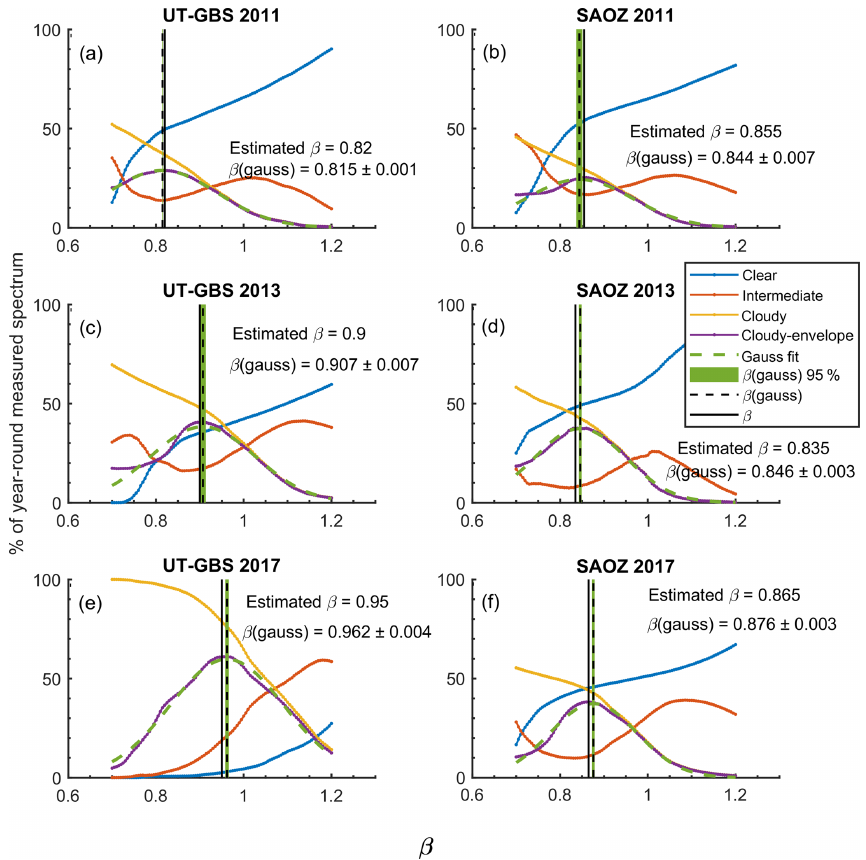
Figure 3. Examples of colour index calibration factor ( β ) determination. The y axis is the percentage of year-round measured spectra, the x axis is the β value used in the calibration. Solid lines represent measurements under different weather categories (blue for clear, red for intermediate, yellow for cloudy, and purple for cloudy envelope). Estimated values for β and the Gaussian fit, β (gauss), are shown by the vertical solid black line and dashed black lines, respectively. The vertical green shaded area is the 95% confidence bound on β (gauss). The instrument name and measurement year are indicated on each panel. Note that any measurements with solar zenith angle (SZA)>85 ◦ have been removed in this calibration